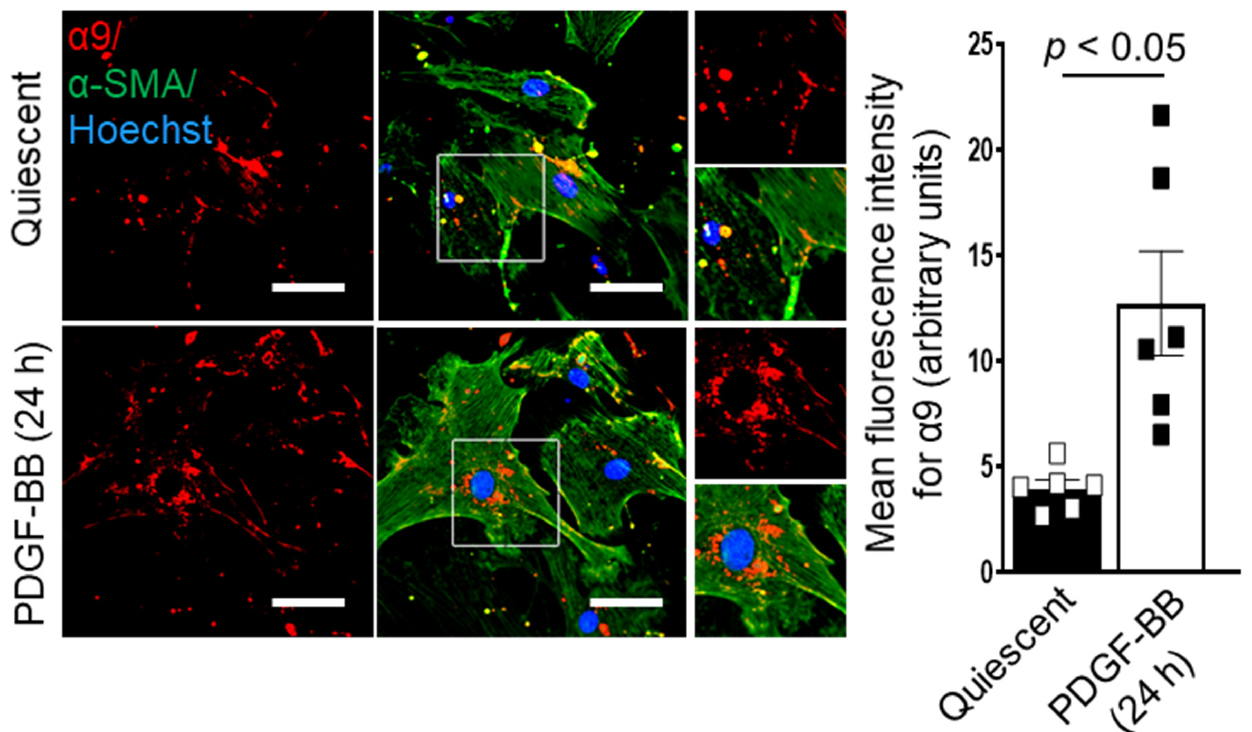
Figure 2. Integrin α 9 expression in murine aortic smooth muscle cell (SMC). (A) Serum-starved murine aortic SMC was stimulated with or without platelet-derived growth factor-BB (PDGF-BB) for 24 h. The left panels show representative double immunostaining for α 9 (red) and α SMA (green) in SMCs stimulated with or without PDGF-BB. Boxed regions are magnified. Scale bars: 30 μ m. The right panel shows the quantification of α 9 fluorescence intensity ( n = 6/group). Statistical analysis: unpaired Student’s t -test.